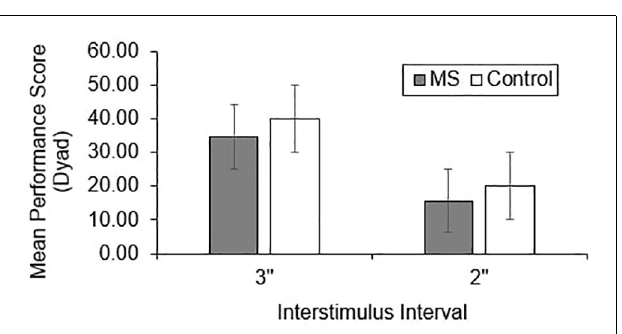
FIGURE 5 | Group difference in dyad cognitive fatigability scores.